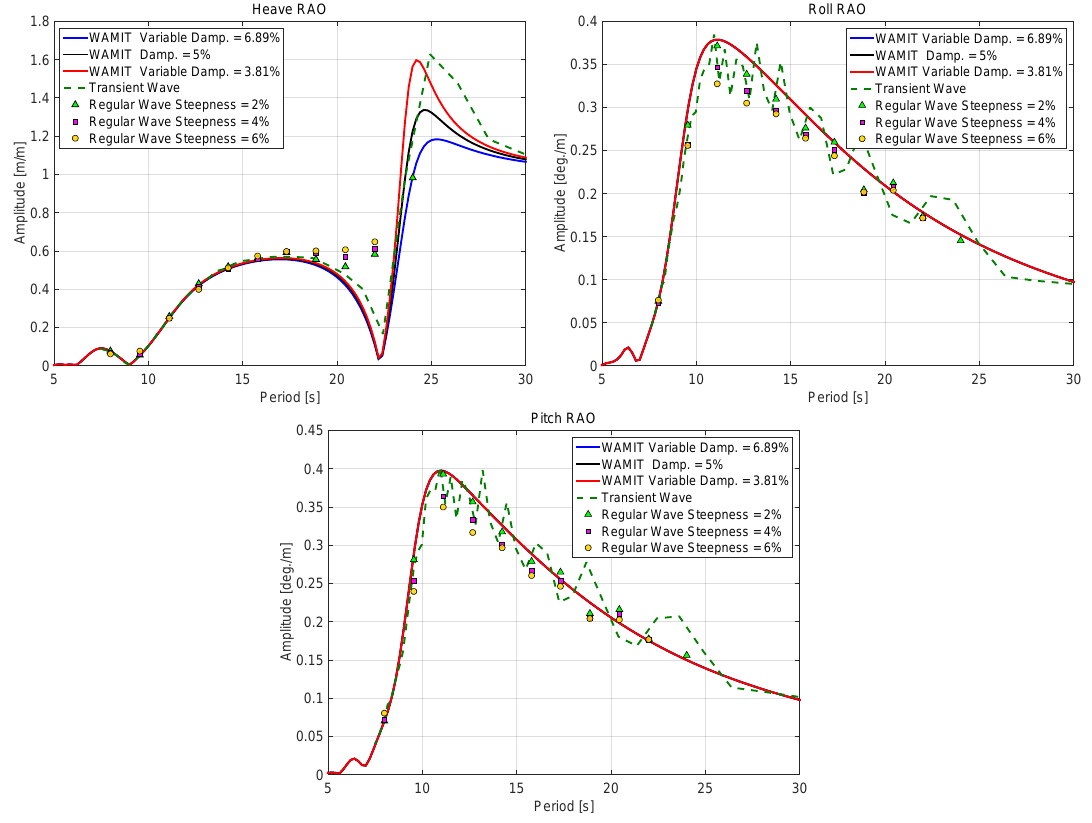
Figure 3. Heave, roll and pitch Response Amplitude OperatorsRAOs estimated numerically (black and blue lines), experimental RAOs obtained using transient (green dashed line) and regular waves with 2%, 4% and 6% steepnesses (colored